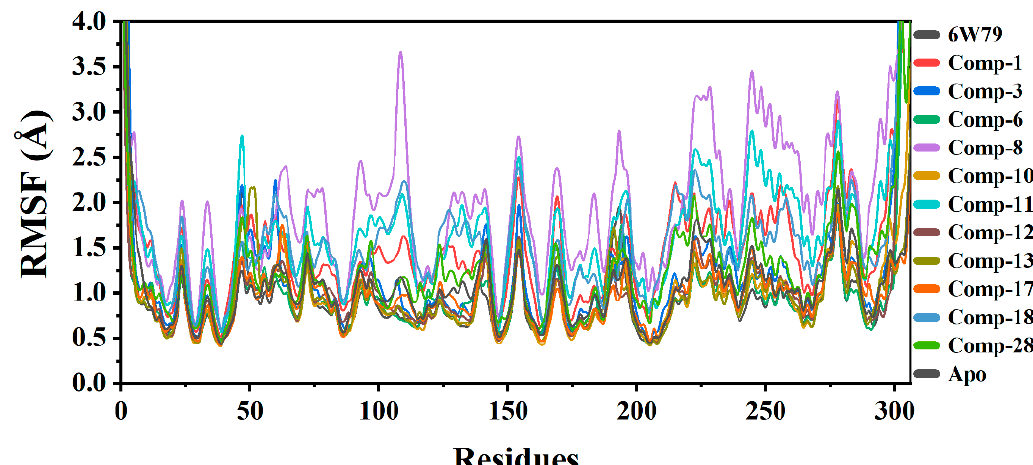
Figure 3. RMSF graphs of apo–M pro , M pro – X77 , and M pro in complex with selected hits. The RMSF of free state was in range of 0.5 Å to 1.3 Å. Compound 8 attained highest RMSF (between 1.5 Å and 3.5 Å), while the complex with X77 showed RMSF between 1.0 Å and 1.8 Å.